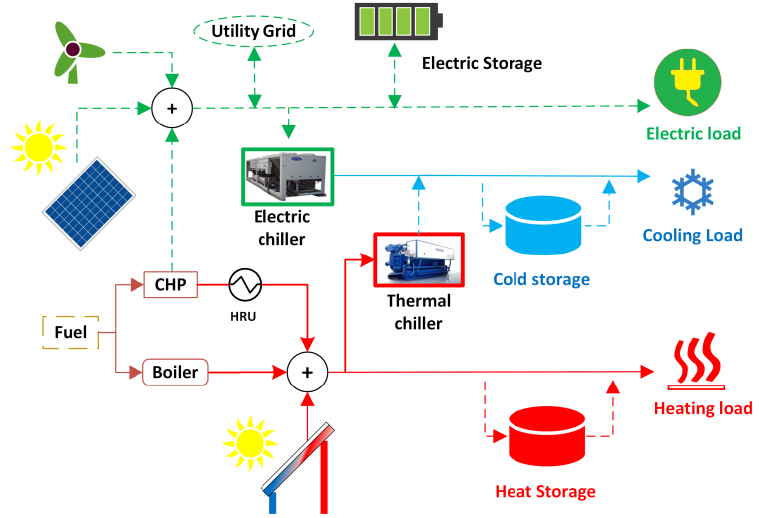
Figure 2. Schematic of the polygeneration system used in this study [11,20].